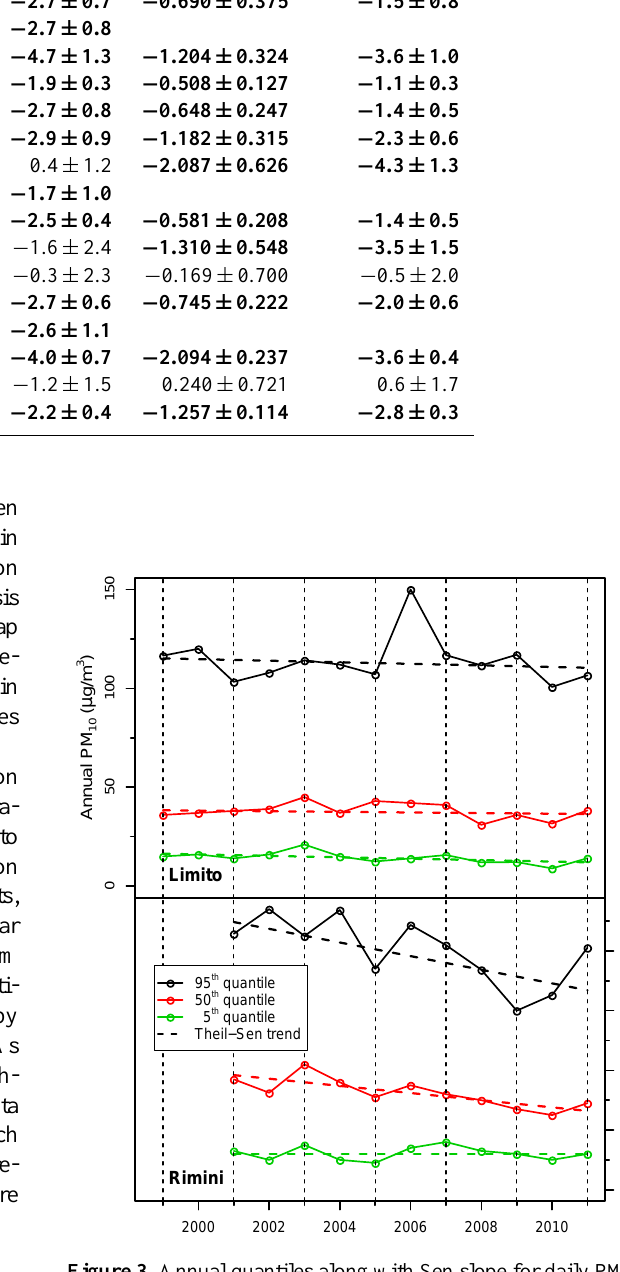
Figure 3. Annual quantiles along with Sen slope for daily PM 10 at Limito and